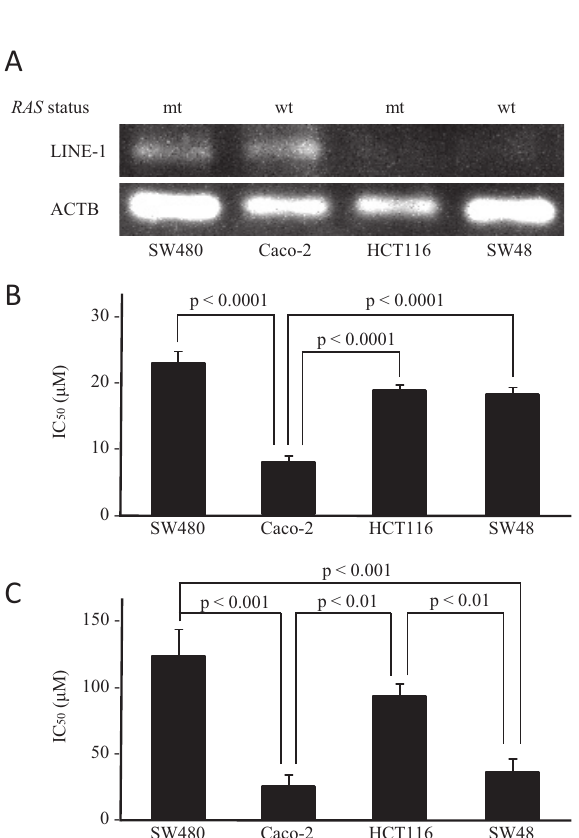
F i g ure 1 The association bet w een LINE-1 mRNA expression and sensiti v it y to EGFR inhibitors in colorectal cancer (CRC) cell lines. ( A ) LINE-1 mRNA is expressed in S W 480 and Caco-2, b u t not in HCT116 and S W 48 cells. RAS stat u s is indicated as w t fo